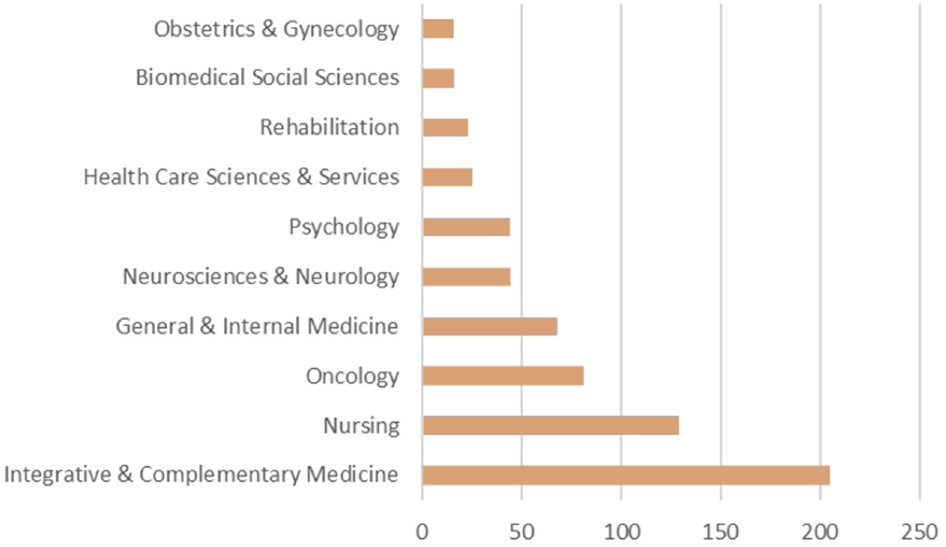
Figure 10. Top 10 research areas for foot reflexology. Figure 9. Top 10 research areas for foot